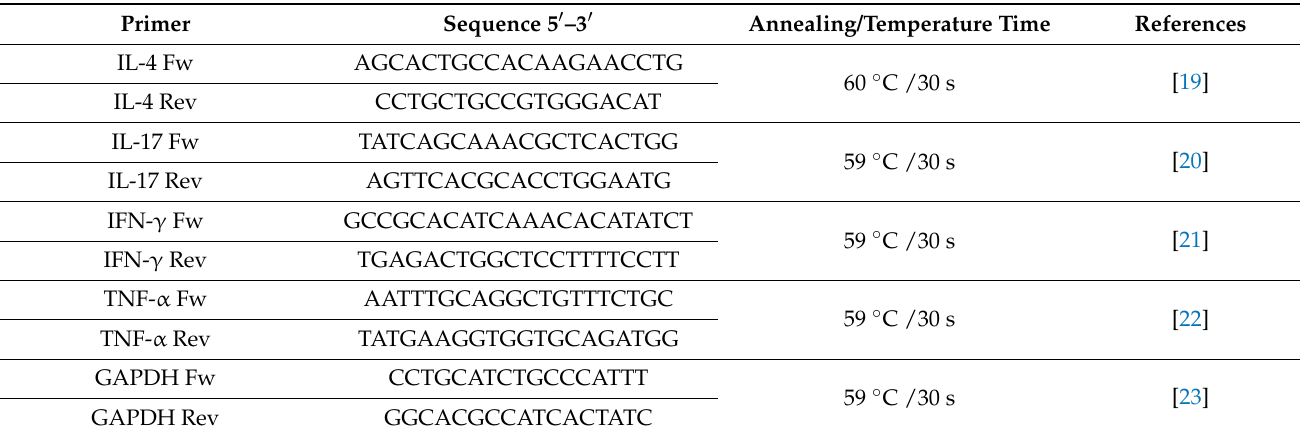
Table 2. List of primers used for the chicken cytokine mRNA